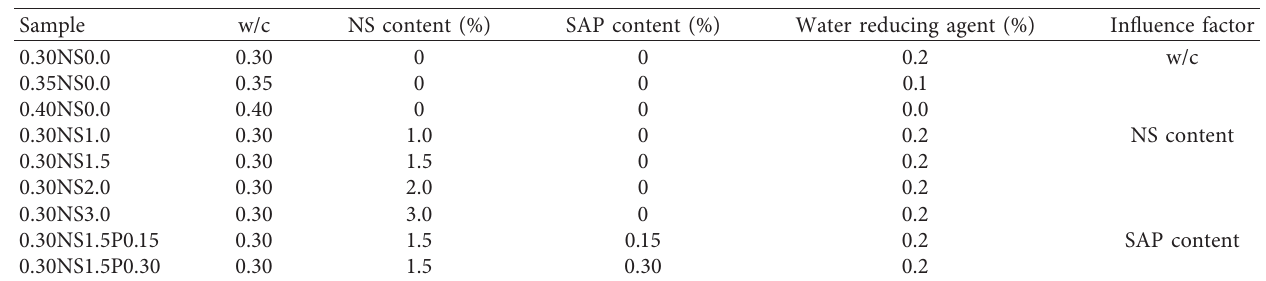
Table 2: Category of cement